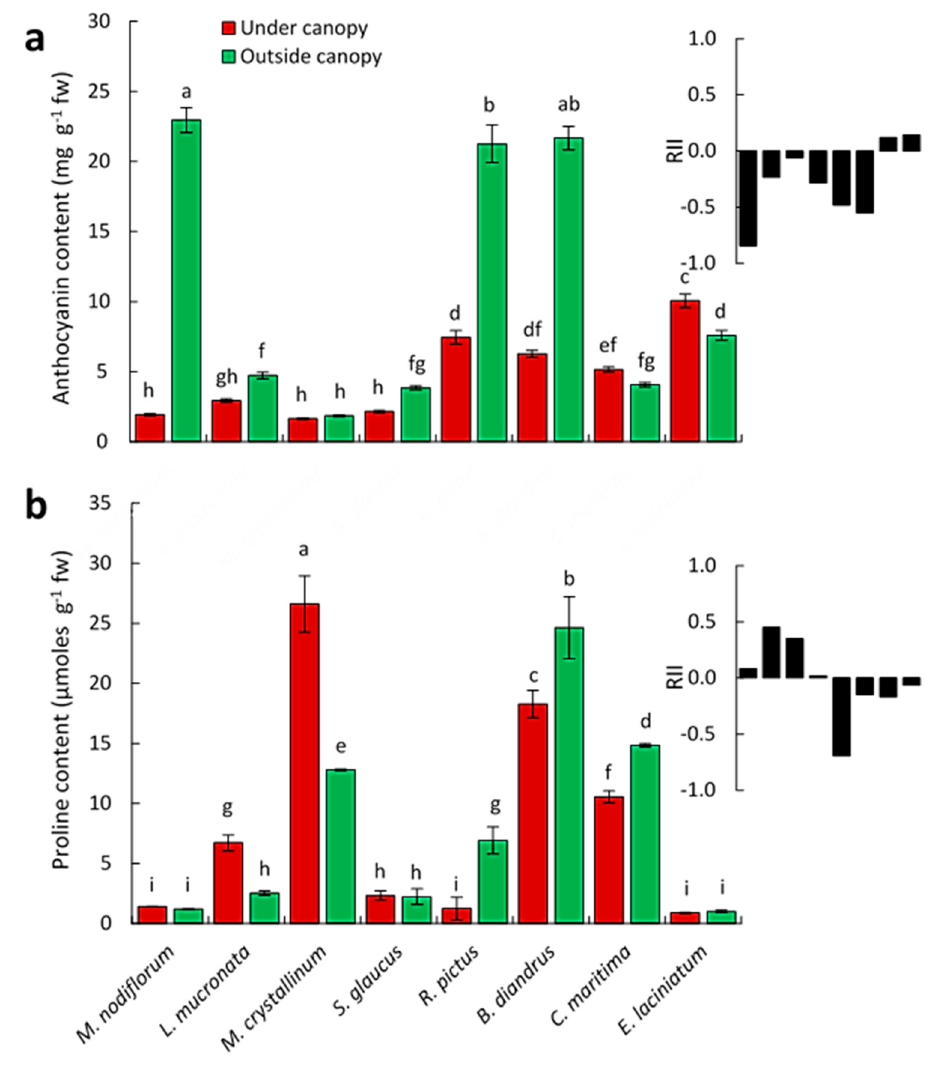
Figure 4. Effect of C. polygonoides shrubs on ( a ) anthocyanin content in the eight selected associated species under and outside. ( b ) proline content. Columns with the same letter are not significantly different after Duncan’s post-hoc test ( p ≤ 0.05). Values are average ± standard error ( n = 5). The relative interaction index (RII) was presented on the right as black columns.